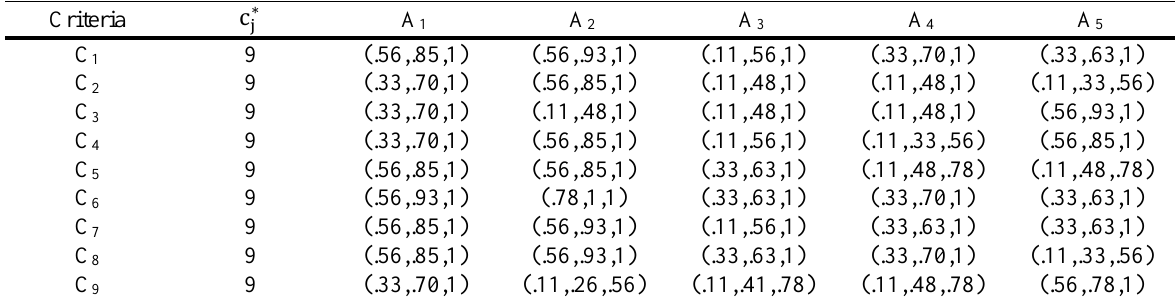
Table 7. Normalized fuzzy decision matrix for alternatives.